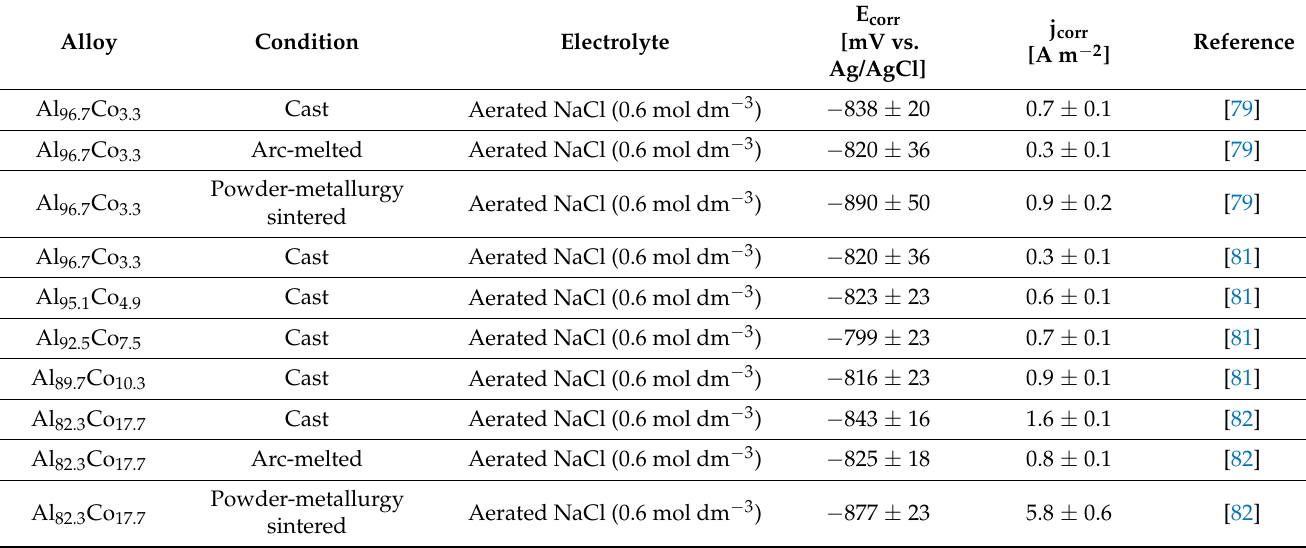
Table 5. Electrochemical corrosion parameters of Al-based complex metallic